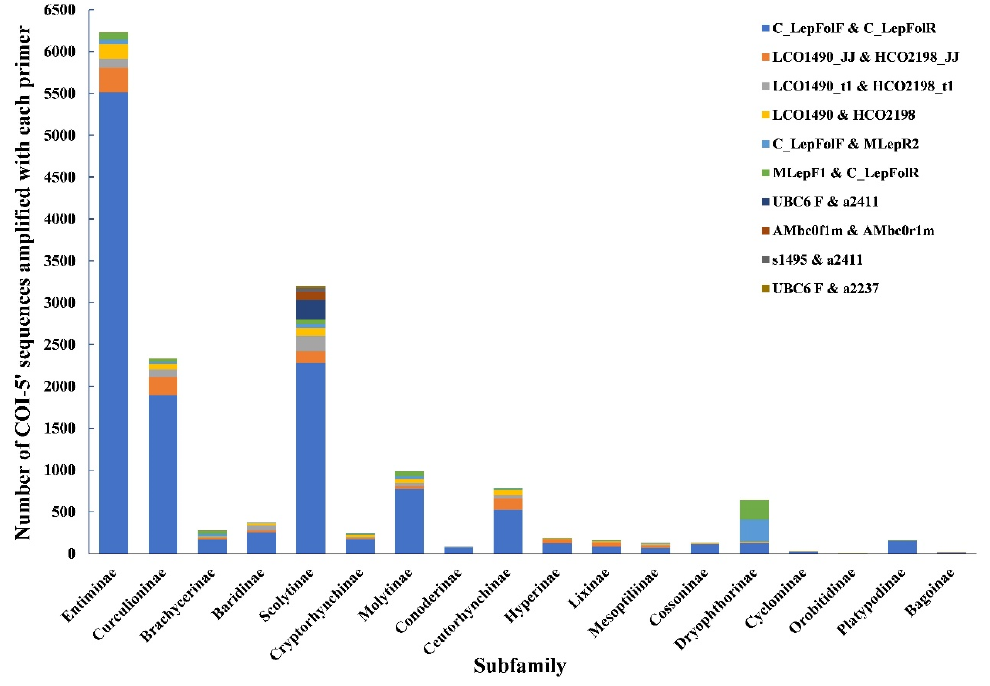
Figure 3. Primers sets used to amplify COI barcode sequences of different subfamilies in Curculio- nidae.